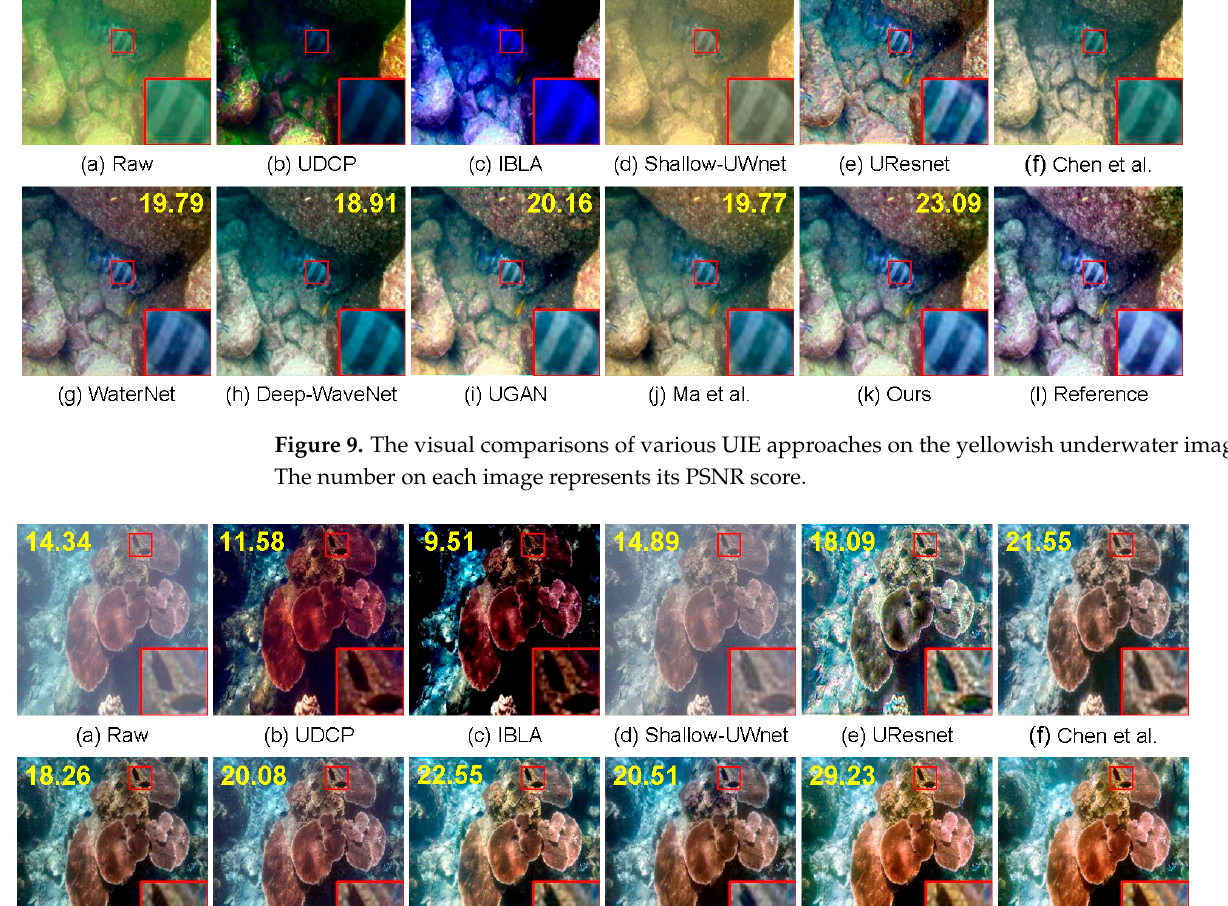
Figure 11. The visual comparisons of various UIE approaches on the low-illuminated underwater images. The number on each image represents its PSNR score.